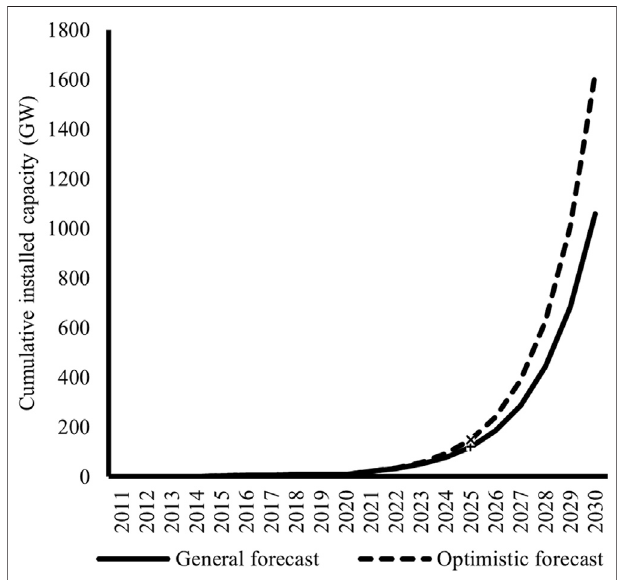
FIGURE 4 | Cumulative installed capacity of centralized PV in Ningxia from 2011 to 2030 under two conditions of general forecast and optimistic forecast.